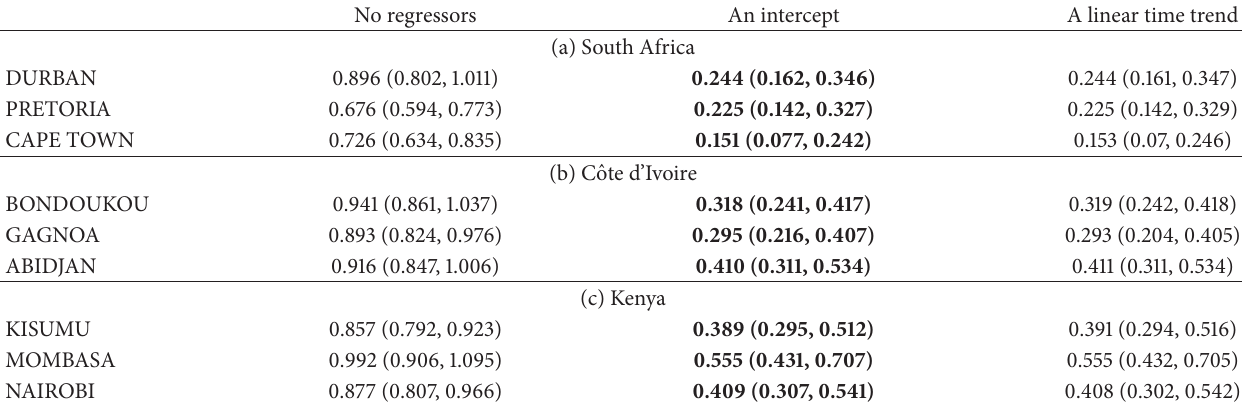
Table 2: Estimates of 𝑑 in the original data using a long memory model with seasonal AR disturbances.